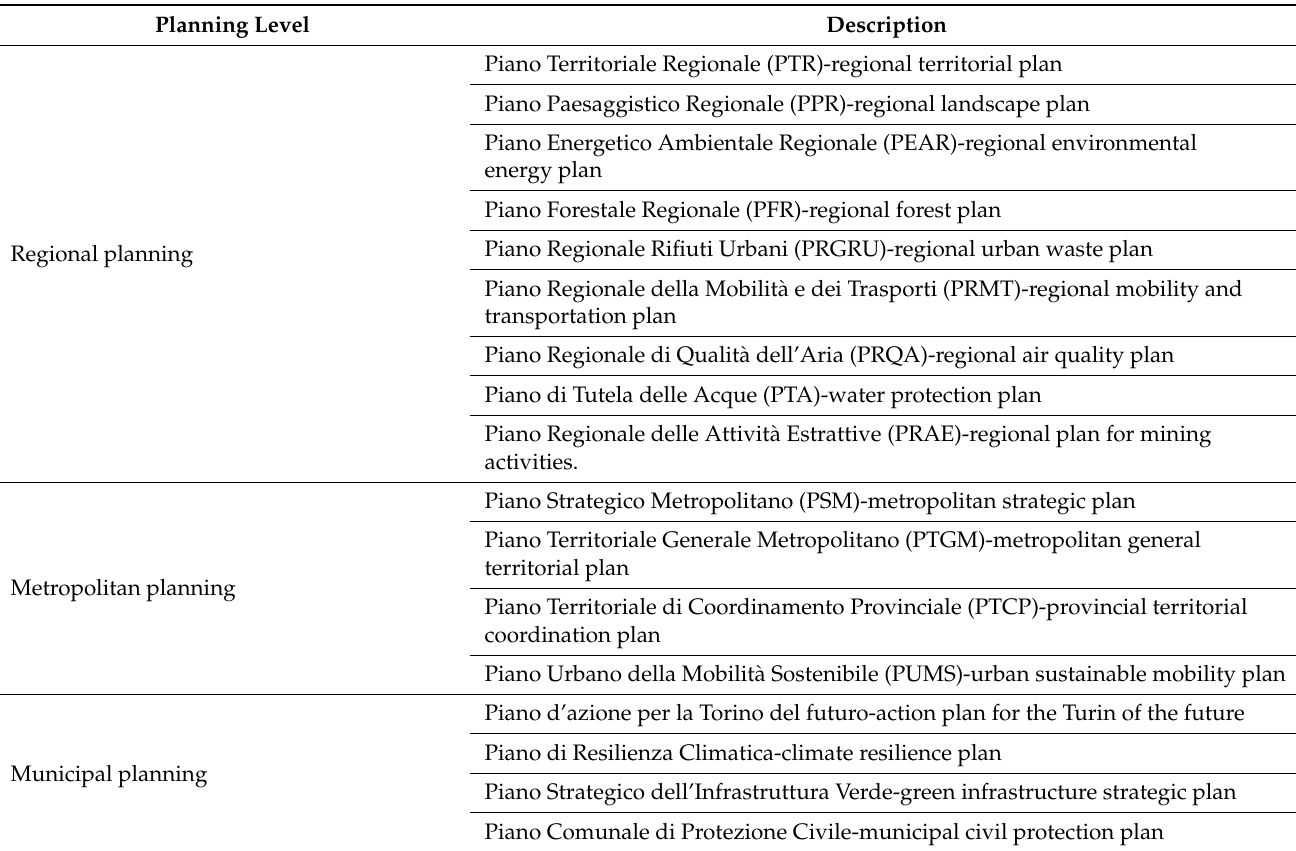
Table 10. The investigated planning tools at superordinate and coordinated levels [29].